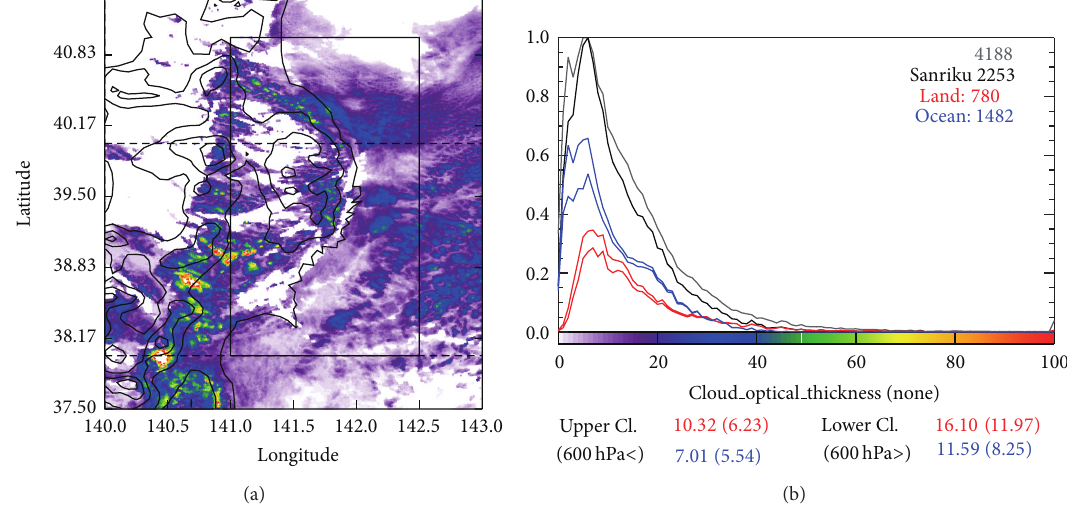
Figure 9: Same as Figure 8 but for cloud optical thickness ( 𝜏